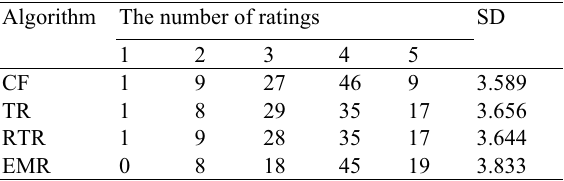
Table 9. Listener’s satisfaction degree in the anxiety